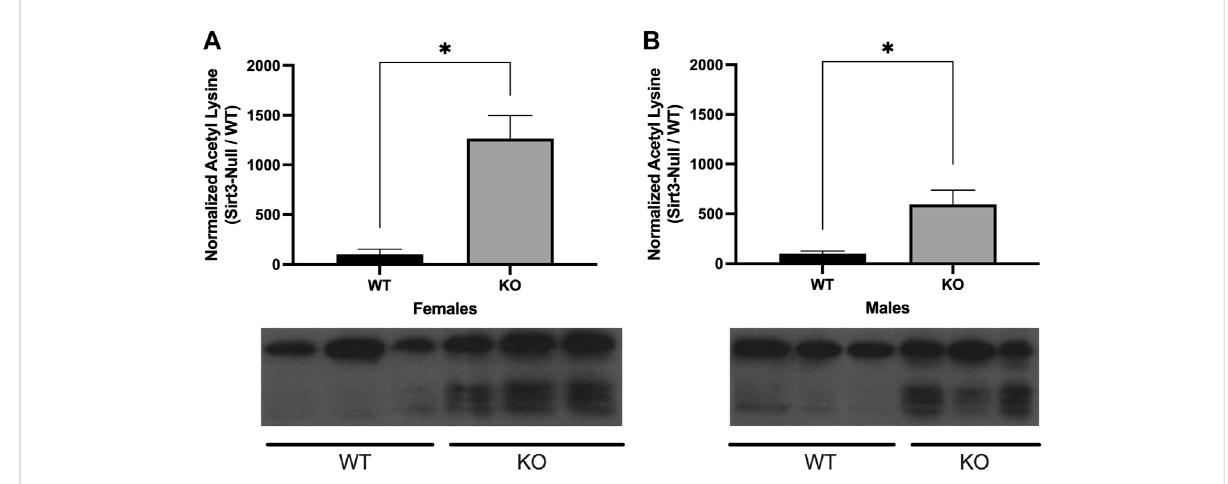
FIGURE 2 Alterations in lysine acetylation levels of whole brain mitochondrial proteins in Sirt3- KO mice. A representative Western blot showing the immunoreactivityofanti-acetylatedlysine.AntibodyinmitochondrialfractionsisolatedfromwholebraintissuesinmaleandfemaleWTandSirt3-KO mice ( n = 3 independent subjects). (A) Female and (B) male Sirt3-KO mice have increases of acetylated lysine in proteins isolated from the mitochondrial fraction of whole brain tissues. The histograms show the densitometric mean and SEM for each speci fi c homogenate